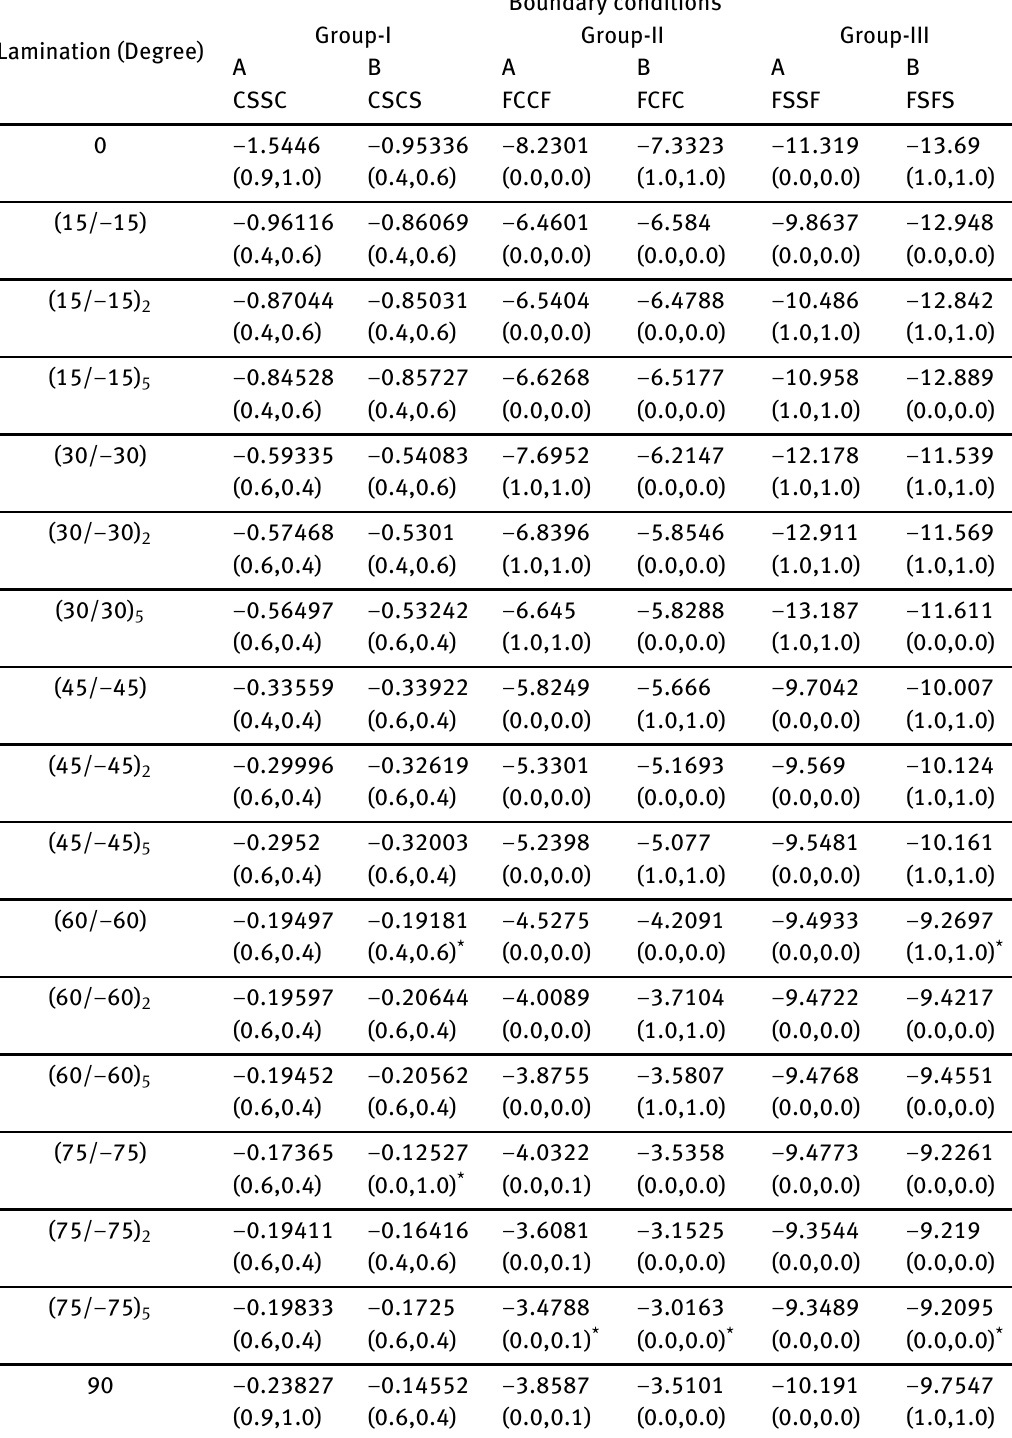
Table 7: Values of maximum non-dimensional compressive in-plane forces (− N y ) for different antisymmetric angle ply lamination and boundary conditions of stiffened composite hypar shell with